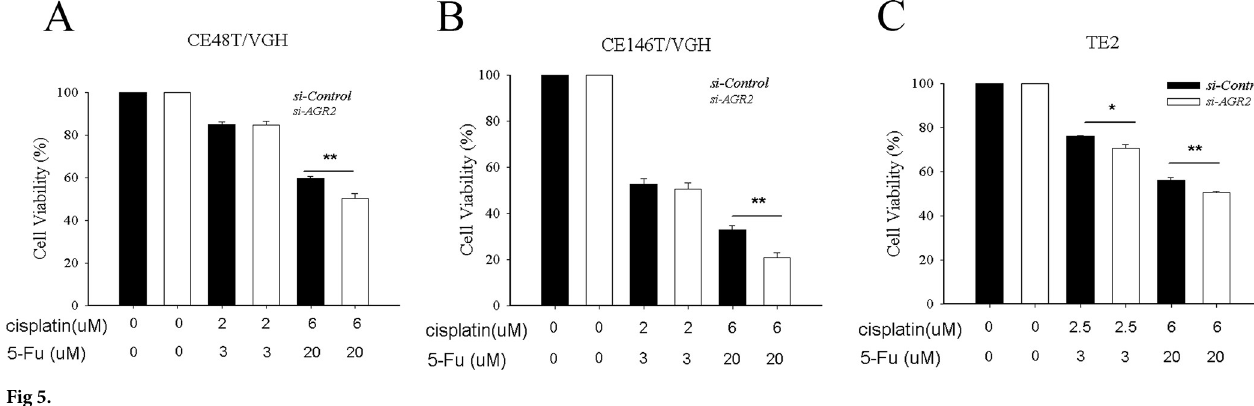
https://doi.org/10.1371/journal.pone.0276990.g005 processes [50]. Lucia et al., [51] showed that the function of AGR2 is reduced by TGF- β and maintains the epithelial phenotype by preventing the activation of key factors involved in the process of EMT in breast cancer. The Orexin receptor type 1 (Ox1R) had pro-apoptotic prop- erties in esophageal cancer [52]. The condition of Barrett’s esophagus is known to precede esophageal adenocarcinoma. AGR2 is universally overexpressed in the epithelium of Barrett’s esophagus and esophageal adenocarcinoma [39, 49]. In esophageal adenocarcinoma, AGR2 expression also promotes tumor growth, cell migration, and cellular transformation [35]. Dong et al., further demon- strated that AGR2 in esophageal adenocarcinoma promotes tumor growth by inducing AGR2 expression of and regulates the Hippo signaling pathway co-activator [53]. Most researchers focused their studies on the relationship between AGRs and adenocarci- noma. However, very few of them considered AGR2 roles in squamous cell carcinoma. Ma et al., [34] reported that in head and neck squamous cell carcinoma, AGR2 expression is asso- ciated with tumor grade and tumor size. They also showed that radiotherapy and